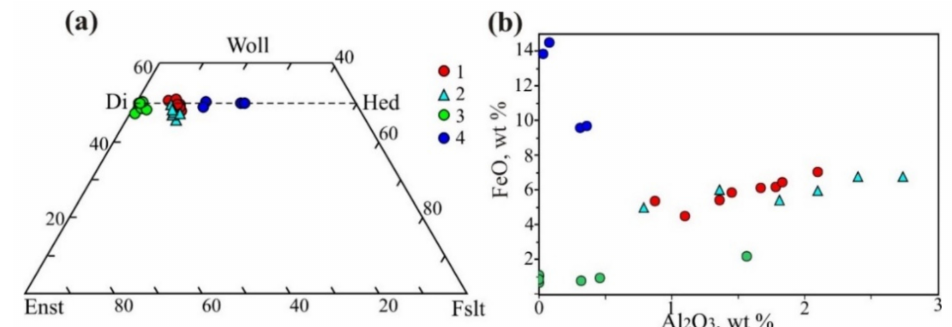
Figure 3. Diagrams of composition of clinopyroxenes ( a ) and contents of FeO-Al 2 O 3 ( b ) in primary and secondary clinopyroxenites. Primary clinopyroxene from clinopyroxenites I (1), II (2), and III (3). 4—secondary clinopyroxene from clinopyroxenite I.